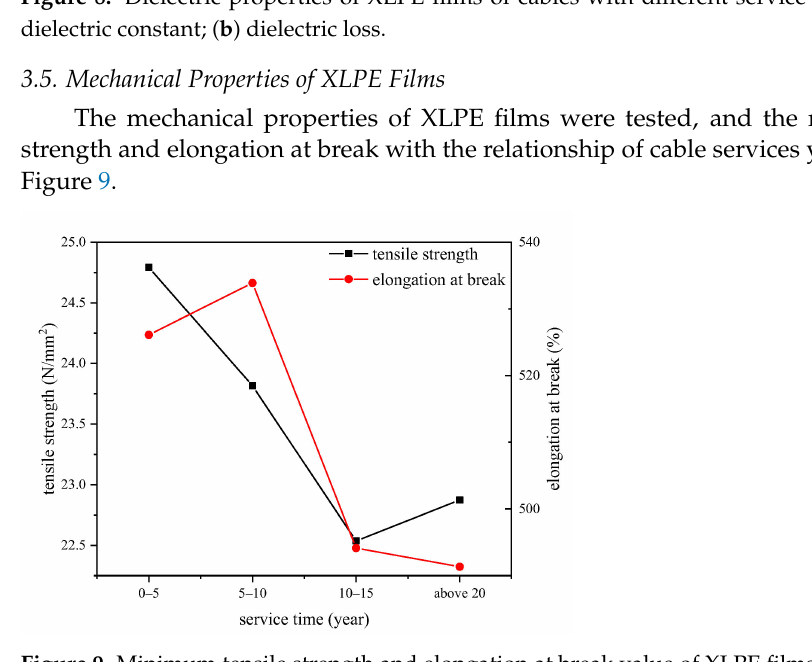
Figure 9. Minimum tensile strength and elongation at break value of XLPE